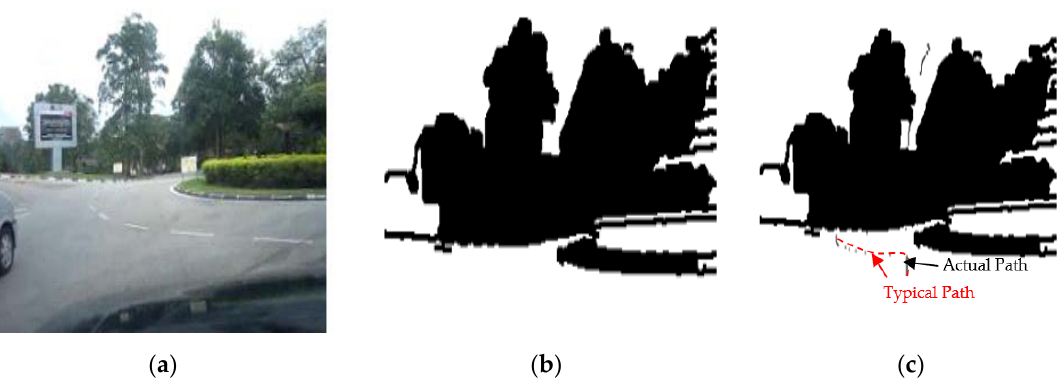
the road roundabout environment.